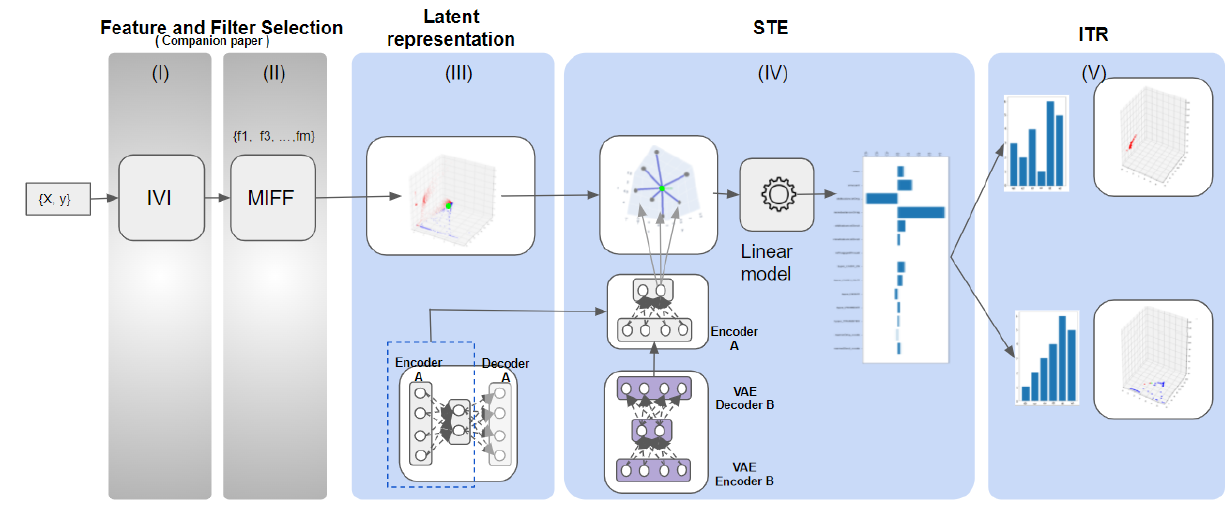
Figure 2. Methodology applied to formulate interpretability. The five steps are schematically depicted here, namely: (I) selection of variables using IVI; (II) filtering of variables through MIFF (maximally informative feature filter); (III) latent space evaluation; (IV) STE modeling; and (V) ITR